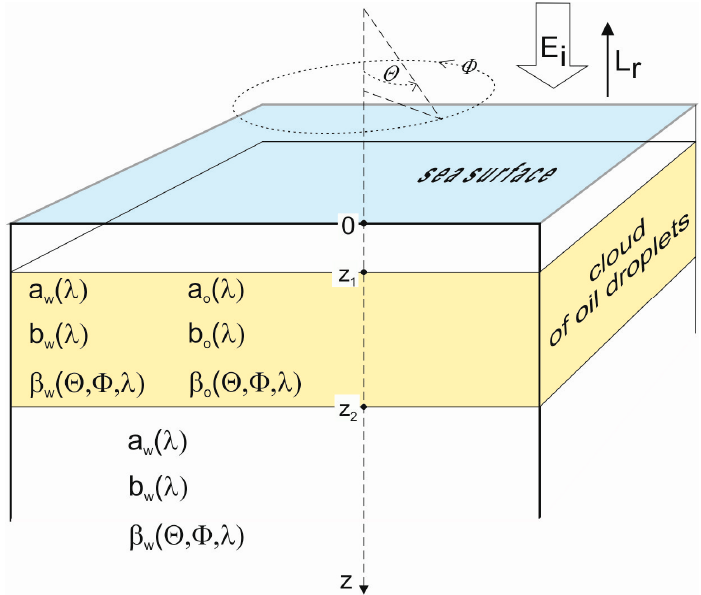
Figure 1. Schematic system of a sea environment polluted with an oil cloud (index w relates to clean water, o—water polluted with oil, and β —volume scattering function).